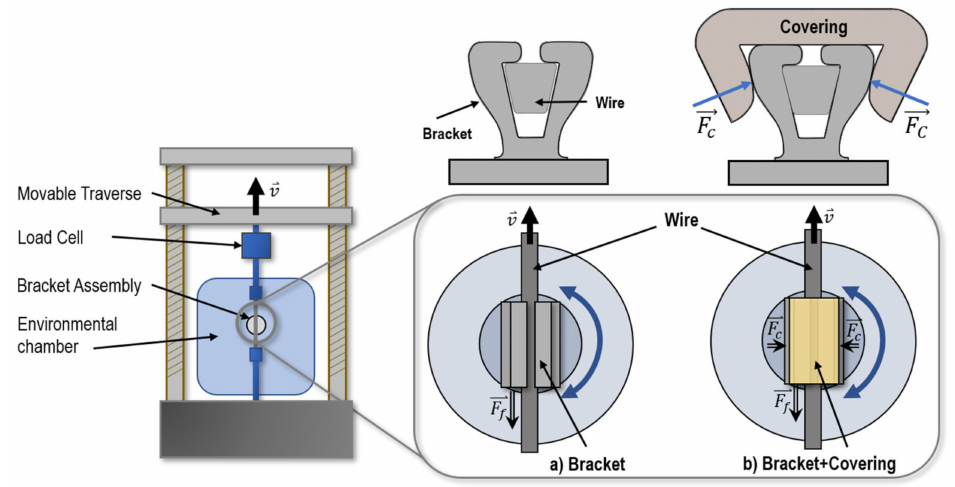
Figure 3. Specimen assembly for friction measurement. The superelastic NiTi bracket was centered and glued onto a hexagonal screw affixed play-free to a ball-bearing axis and was used to minimize canting of the wire. The superelastic NiTi wire (active A f -temperature: 18 ◦ C) was connected to the force sensor of the universal testing machine and moved 5 mm upwards during frictional force measurements. The picture indicated with the letter ( a ) shows the bracket without covering. In the picture on the right, ( b ), a friction-increasing covering was applied to the bracket. Furthermore, the direction of the various force vectors are shown in the figure: F f is the measured friction force, while F c is the force induced by the covering to the bracket-wire